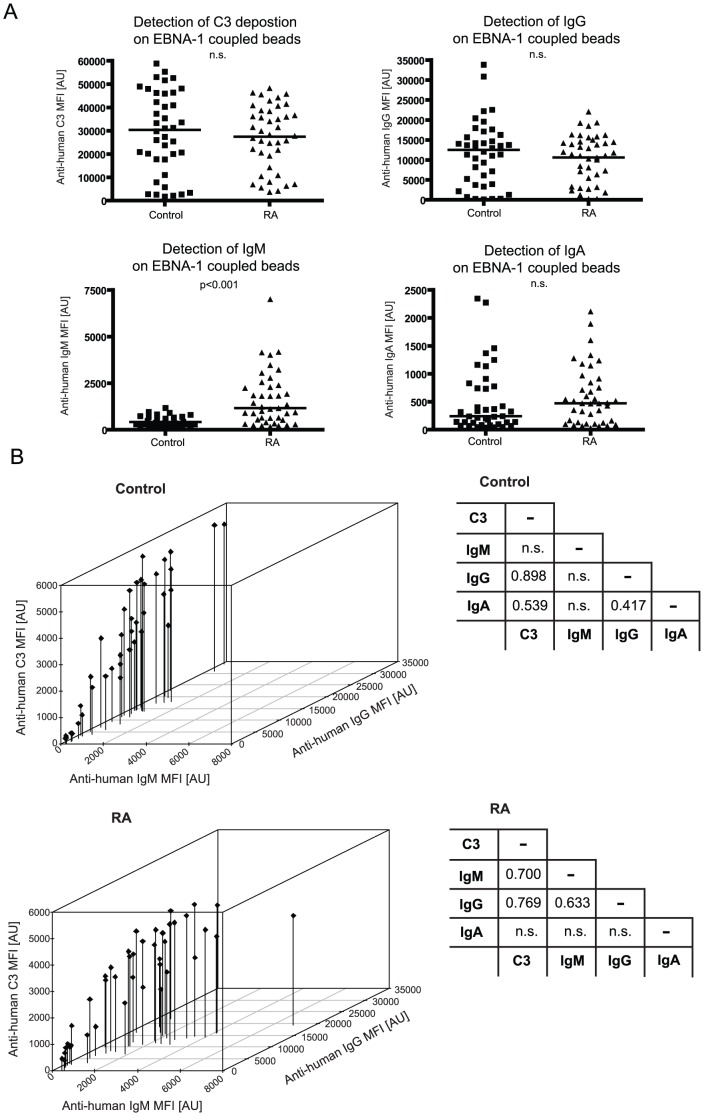
Level of EBNA-1 specific antibodies and their complement activation.EBNA-1 coupled beads were incubated with sera of RA patients and controls. A
) Levels of bound human IgG, IgM and IgA antibodies along with the degree of complement activation are plotted for the two groups. Mann-Whitney non-parametric statistical test was used to calculate the statistical difference between the two groups. B
) Signal intensities for anti-IgM, anti-IgA and anti-C3 for the controls (upper panel) and RA patients (lower panel) are plotted in a 3D graph. The tables show the Spearman's Rho correlation coefficients between anti-C3, anti-IgG, anti-IgM and anti-IgA signal intensities calculated separately for the control and RA patient groups. Only statistically significant (p-value<0.05) correlation coefficients are shown and non-significant correlations are indicated by (n.s.).